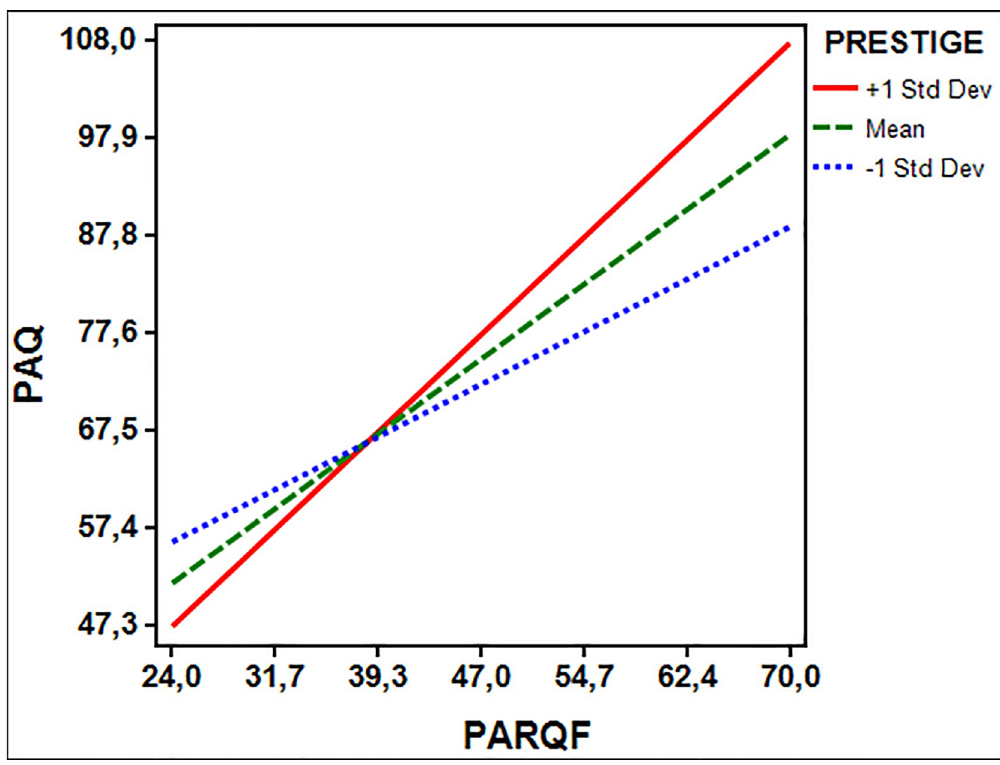
Fig 3. Paternal acceptance-rejection predicting psychological maladjustment at varying levels of prestige in late childhood (9–10 years old). PAQ = psychological maladjustment (higher scores indicate maladjustment); PARQF (higher scores indicate paternal